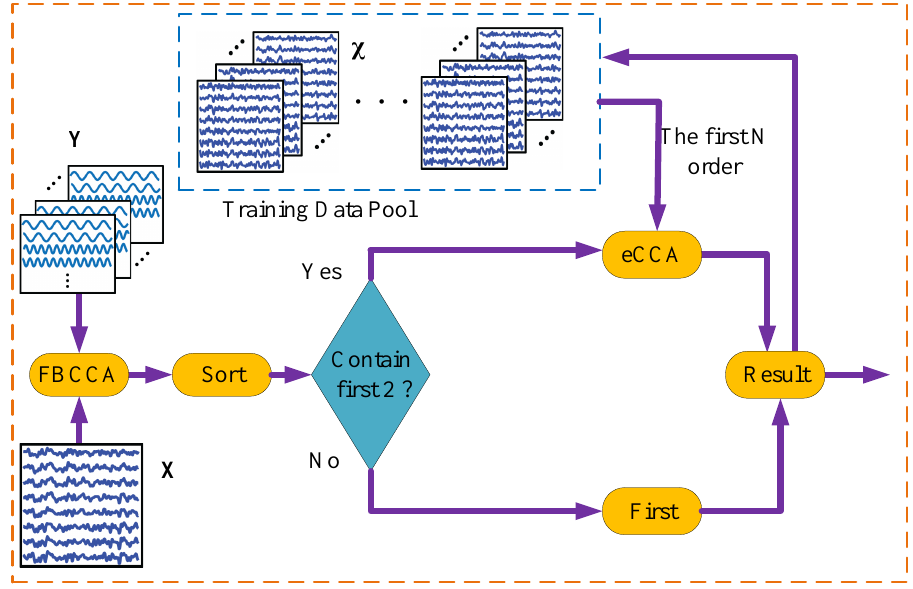
Figure 2. The flowchart of the turbo strategy for SSVEP-based